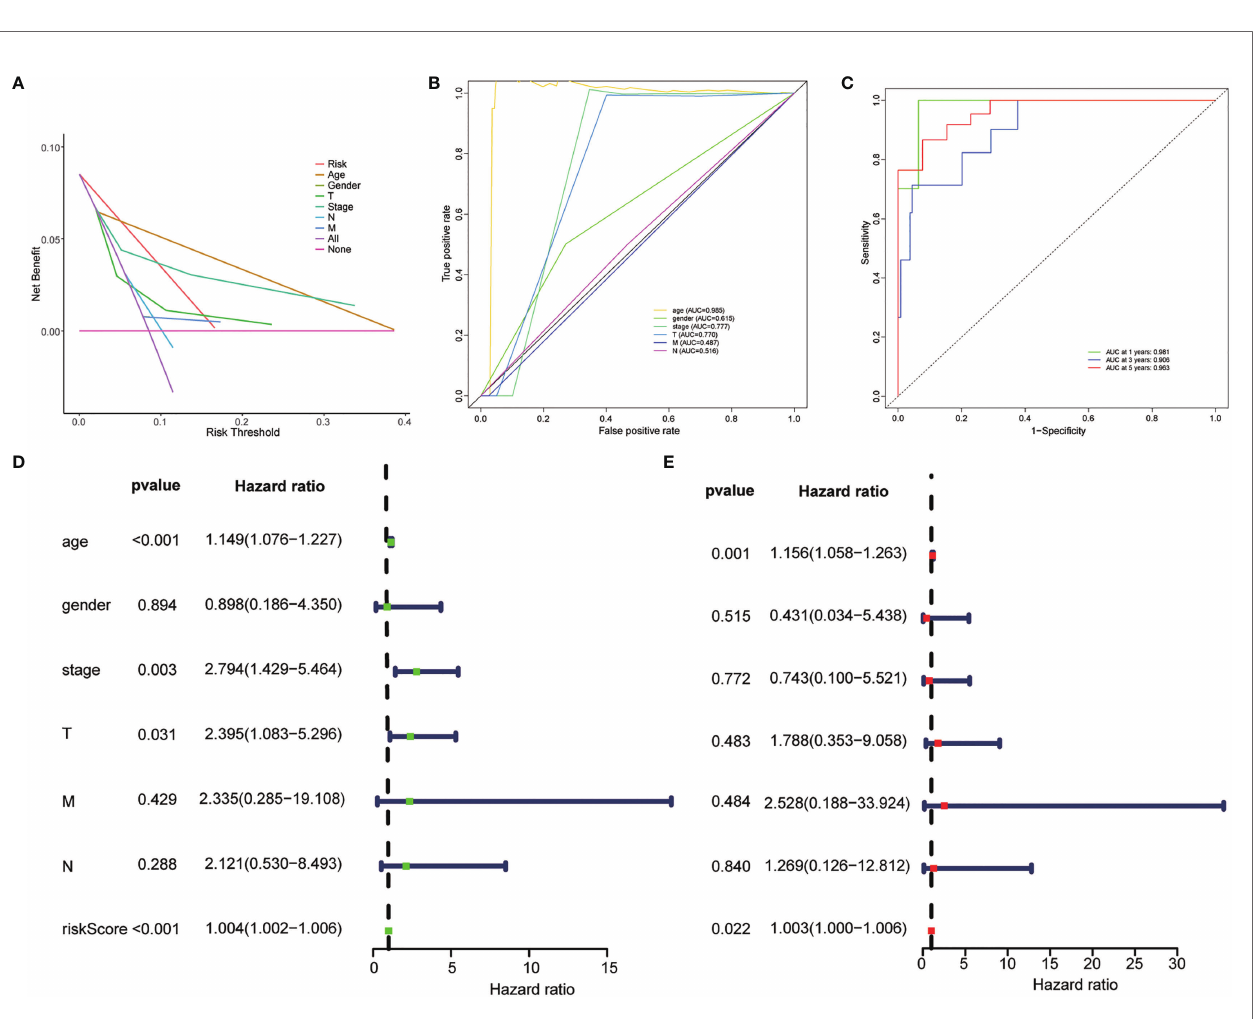
FIGURE 3 | Evaluation of the clinical utility of the risk strati fi cation. (A) DCA curve was drawn based on the risk strati fi cation. (B) The area under the curve (AUC) value of clinical features according to the receiver operating characteristic (ROC) curves. Clinical features: Age, TNM stage, gender, T (tumor size), N (lymph node metastasis), and M (distant metastasis). (C) ROC curve of the risk strati fi cation showing the prognostic performance of the autophagy-related long noncoding RNA (lncRNA) risk strati fi cation. (D) The univariate Cox regression analysis of the risk model score and clinical features regarding prognostic value. (E) The multivariate Cox regression analysis of the risk model score and clinical features regarding prognostic